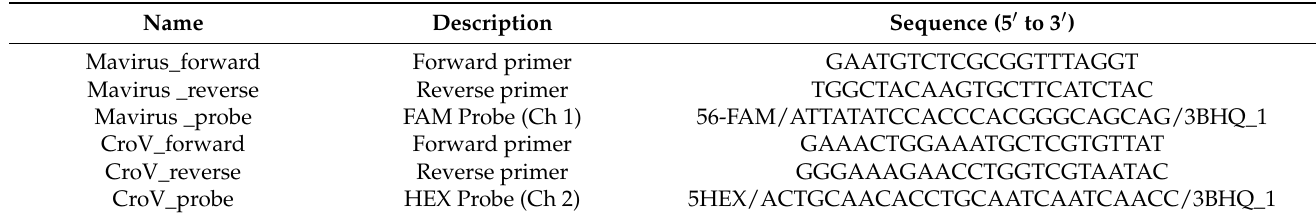
Table 1. Primers and